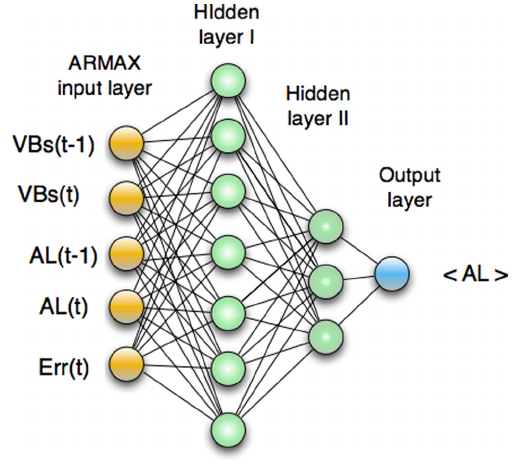
Fig. 1. A schematic representation of the ARMAX – neural net-